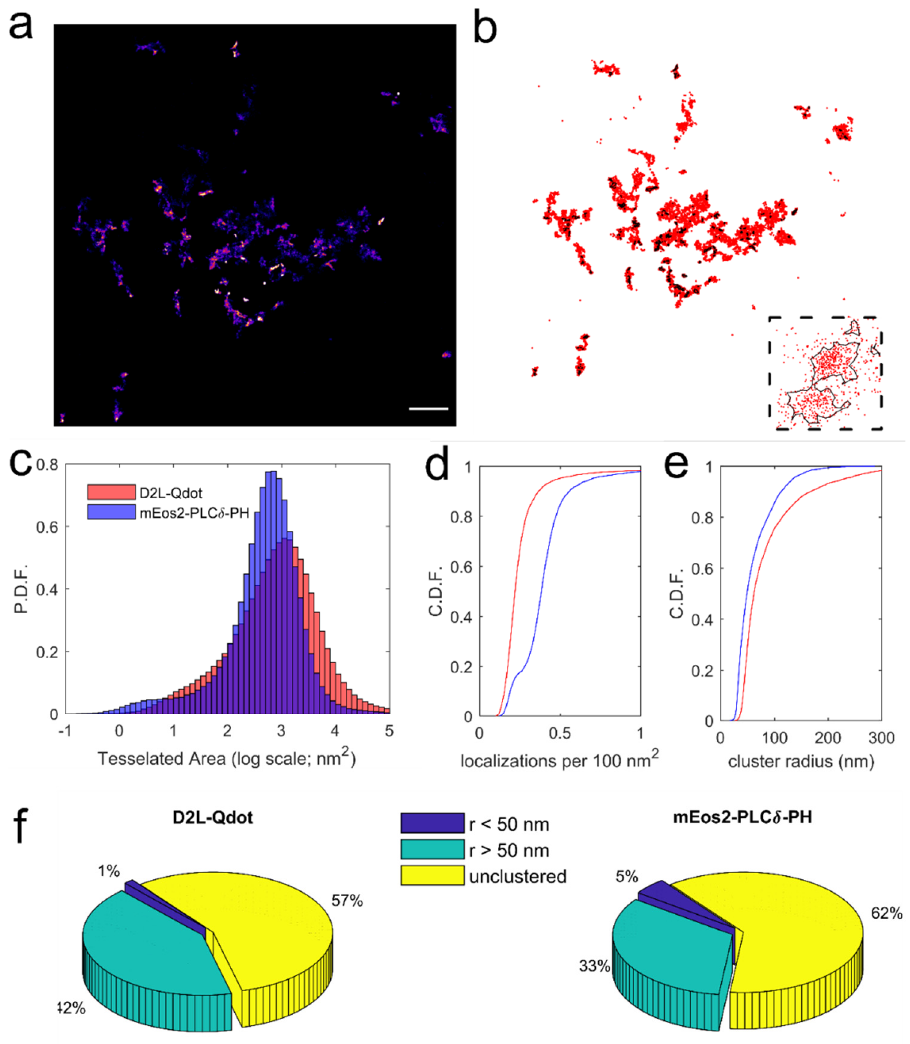
Figure 6. Comparison of Vorono ї tessellation-based cluster detection for movies of Qdot-D2L acquired via nonstochastic SPT versus stochastic sptPALM of mEos2-PH-PLC δ . ( a ) A representative ThunderSTORM super-resolved map of Qdot-tagged wild-type D2L localizations is shown (scale bar: 10 µ m). ( b ) A Vorono ї diagram computed for Qdot-D2L detections (red) is displayed, with identified clusters shown with black contours. ( c ) Histograms of individual Vorono ї cell areas are plotted for both Qdot-D2L localizations (1,221,987 detections from 10 movies) and mEos2-PH-PLC δ detections (817,041 detections from 4 movies). ( d ) Cumulative frequency plots of localization density per 100 nm 2 of identified clusters are shown for Qdot-D2L (red; 4117 clusters) and mEos2-PH-PLC δ (blue; 4246 clusters). ( e ) Cumulative frequency plots of cluster radius are shown for identified localization clusters of Qdot-D2L (red) and mEos2-PH-PLC δ (blue). ( f ) Fractions of Qdot-D2L and mEos2-PH-PLC δ detections found in smaller clusters (r < 50 nm), larger clusters (r > 50 nm), and unclustered form are displayed as three-dimensional pie